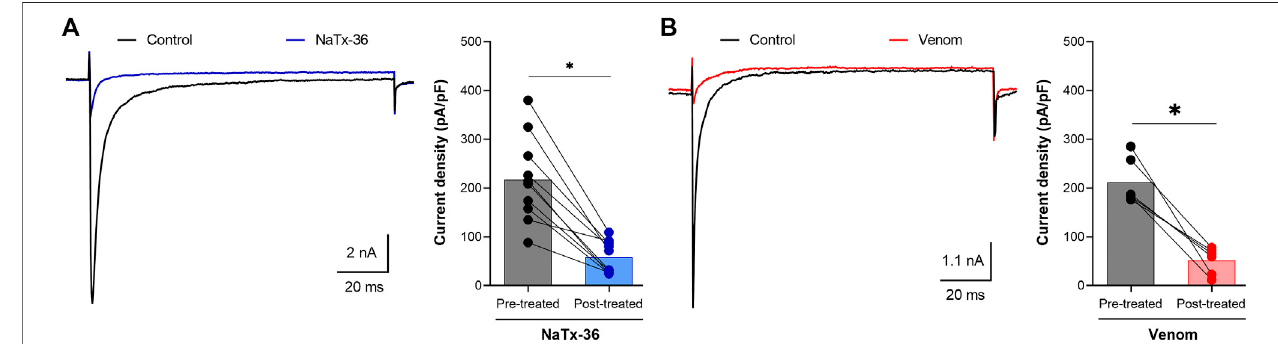
FIGURE 2 | Effects of NaTx36 on grasshopper mouse recombinant OtNa V 1.8 Na + current density. Na + currents were elicited by a 100-ms depolarization to +20 mVfromaholdingpotentialof − 80 mV.Tetrodotoxin(TTX,500 nM)wasaddedtothebathsolutiontoblockendogenousTTXsensitiveNa +